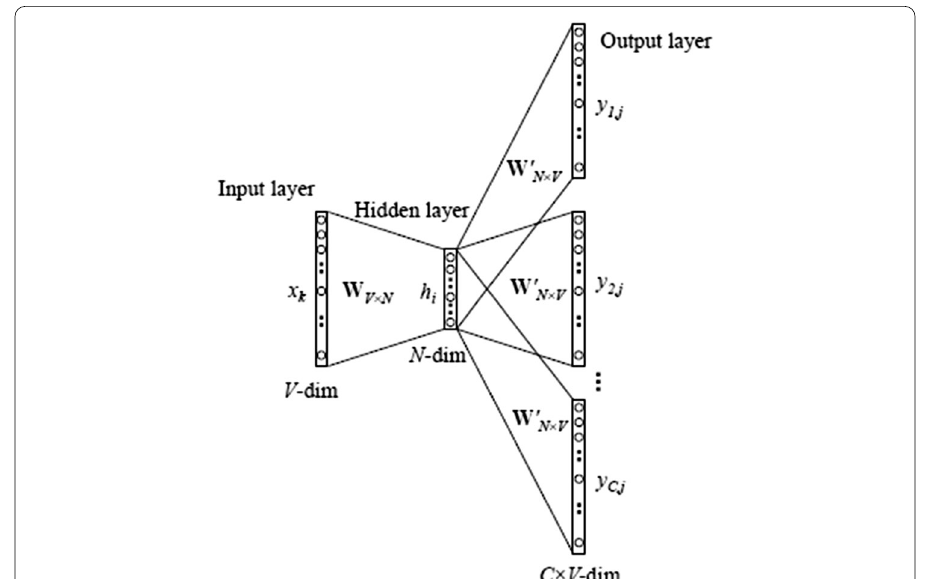
Fig. 13 Graphical representation of Skip Gram method with C context words for target word at position k . Note The picture is taken from (Rong